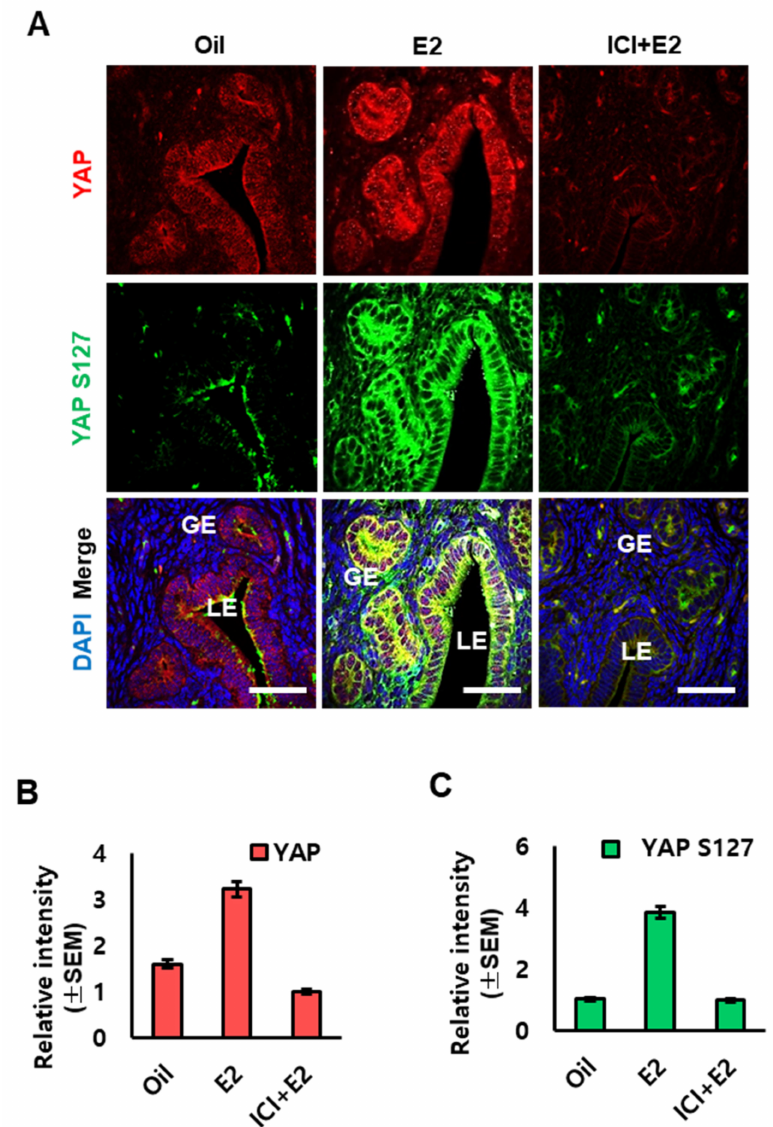
Figure 4. Effects of the estrogen receptor antagonist (ICI 182, 780, ICI) on the levels of YAP and phospho-YAP (YAP S127) in the uterus of OVX mice. ( A ) Cross-sections of uterus from sesame oil (oil; control), E2 only, and/or ICI+E2-treated OVX mice were stained with rabbit polyclonal